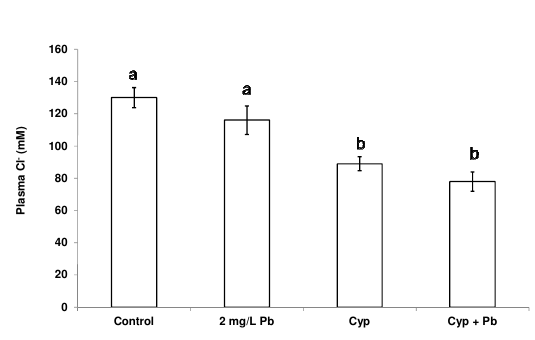
Fig. 2. Mean (±SE, n=6) plasma Cl - in C. gariepinus exposed to either borehole water (control), 2 mg/L Pb, 0.5µg/L cypermethrin or 0.5µg/L cypermethrin + 2 mg/L Pb.. Bars with different letters are significantly different